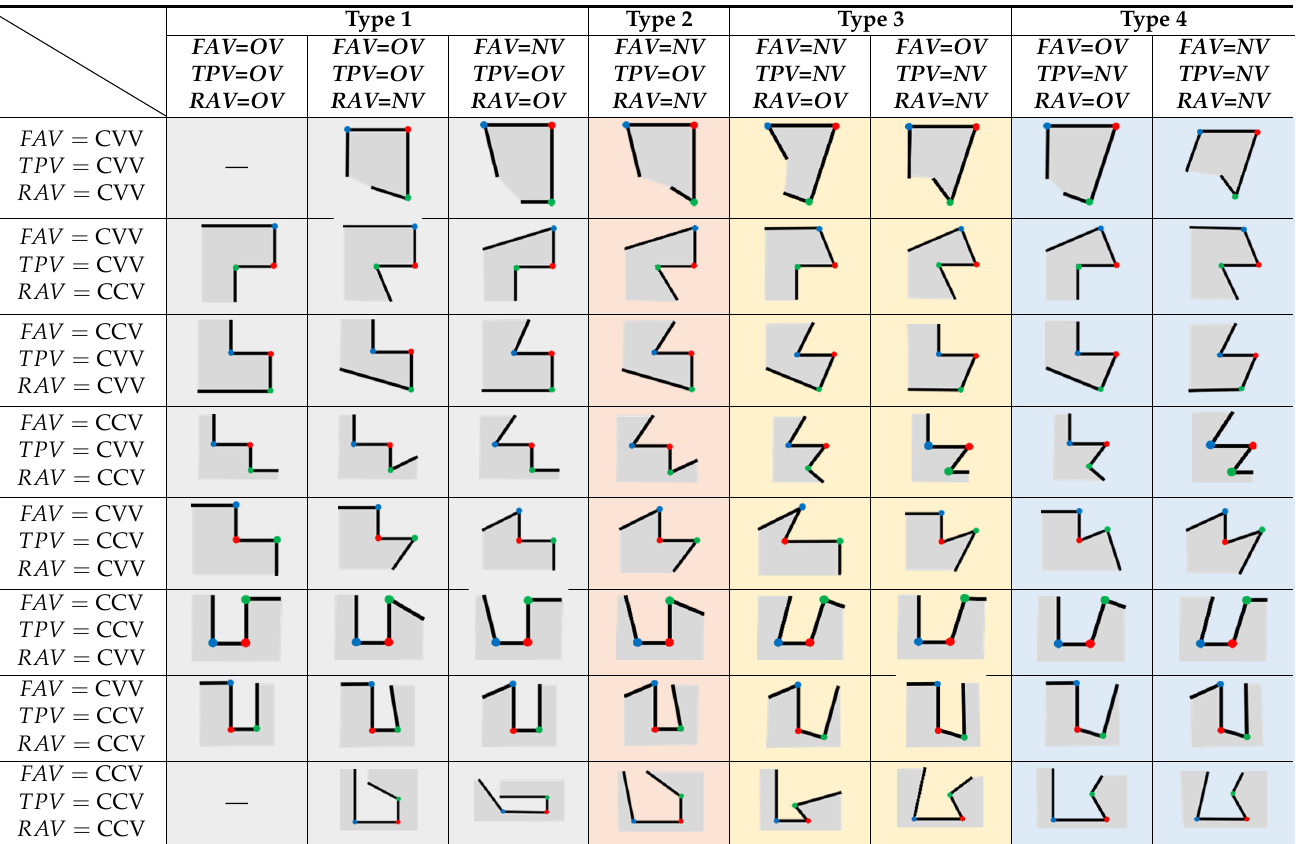
Table 2. Classification of TPS with concave–convex and orthogonality.